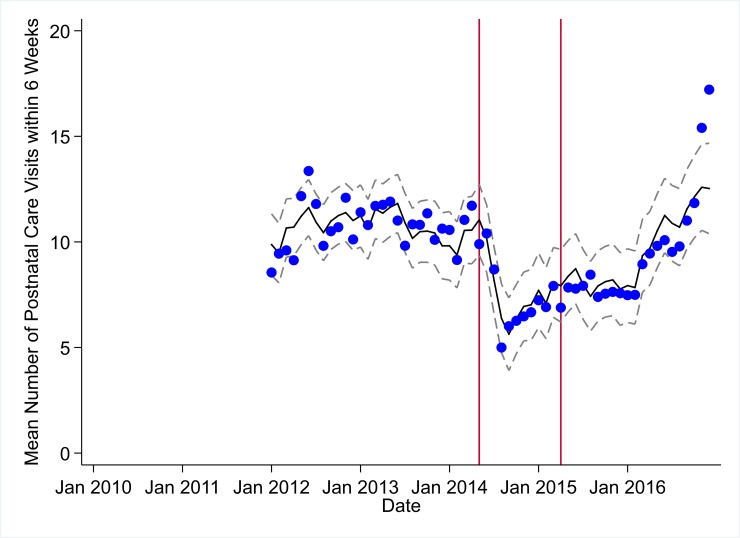
Mean trends and system losses due to Ebola virus disease (EVD) outbreak (June 2014–April 2015) for postnatal care within 6 weeks in a census of 379 clinics providing services in Liberia from 2010–2016, excluding Montserrado County.The black solid line represents the fitted mean from a linear mixed model using a segmented regression parameterization, random intercepts and slopes by facility, monthly indicator variables to adjust for seasonality, a fixed effect to adjust for clinic-level catchment area, and an AR(1) structure to account for autocorrelation in residual errors. Gray dashed lines are 95% confidence intervals around the fitted mean. Red lines are placed at the final month before the start (May 2014) and end (April 2015) of the EVD outbreak in Liberia.